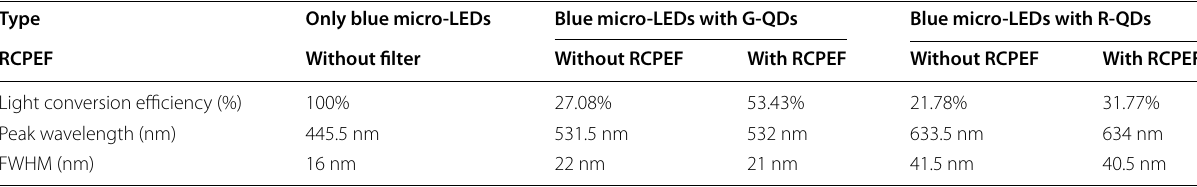
Table 2 Comparison of blue micro‑LEDs with differing